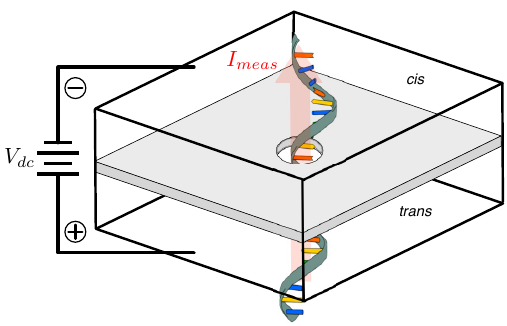
Figure 4. Oblique view of simplified nanopore structure. A thin, pore-infused, membrane separates the cis and trans chambers biased with DC voltage V dc .